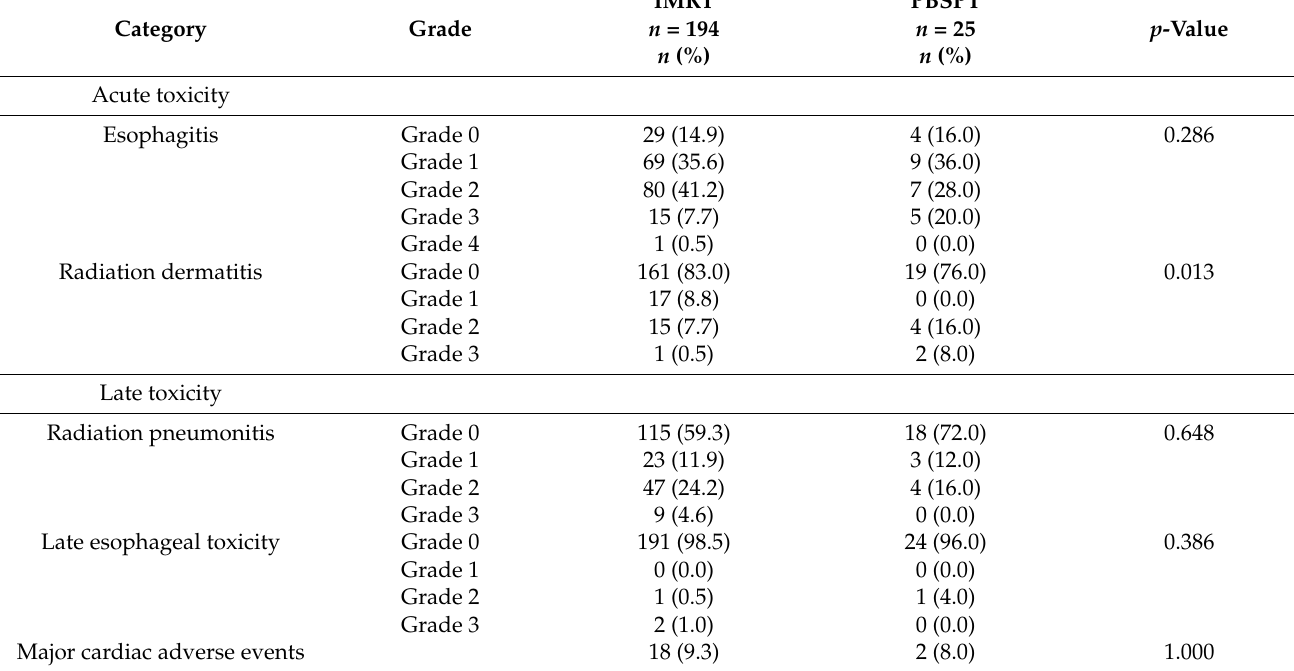
Table 3. Detailed profiles of treatment-related adverse events